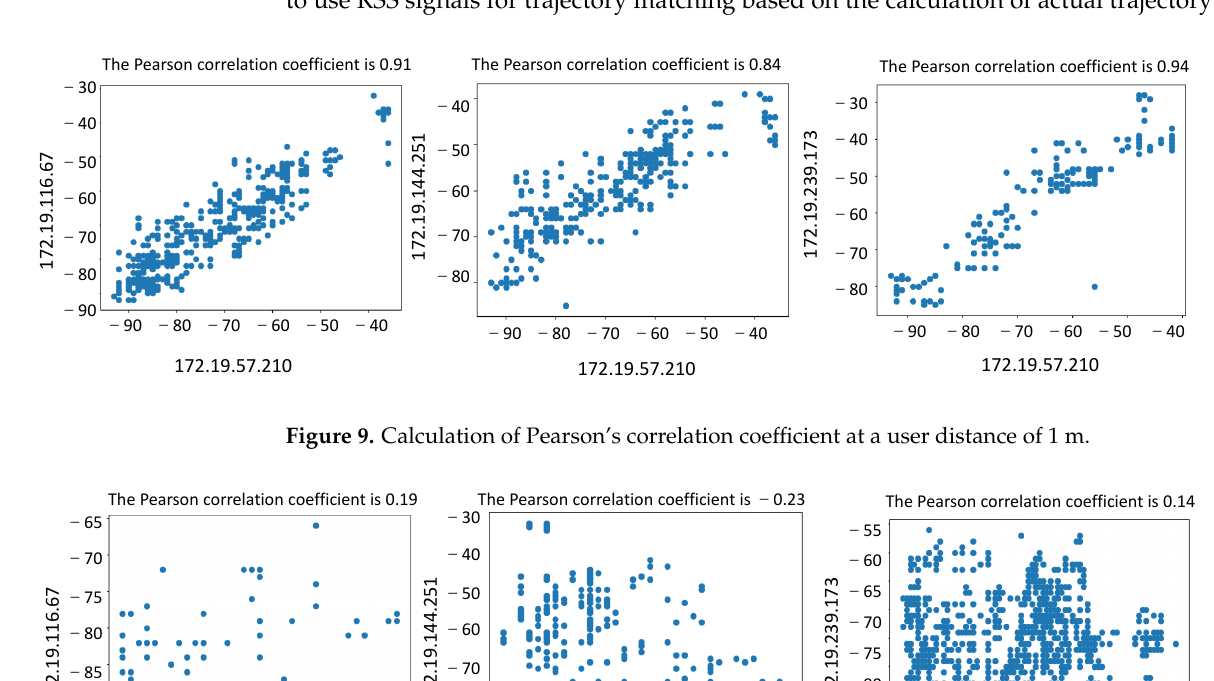
Figure 10. Calculation of Pearson’s correlation coefficient at a user distance of 10